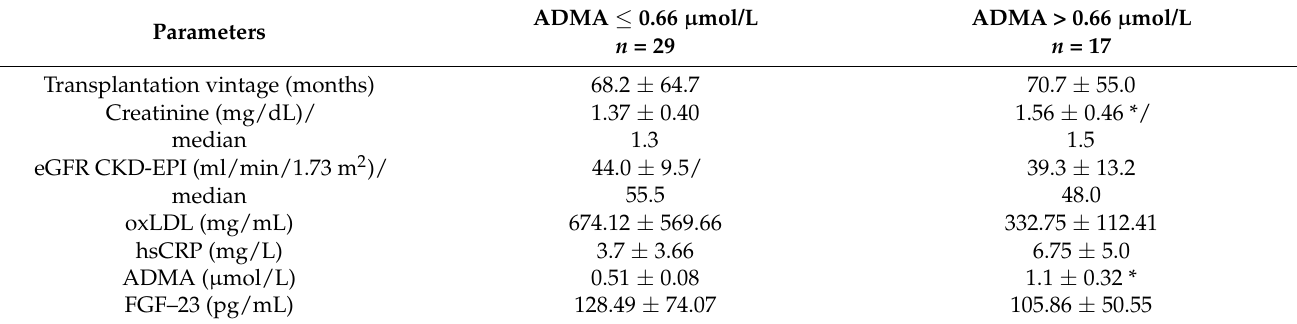
Table 2. The comparison between KTRs with ADMA ≤ 0.66 and > 0.66 µ mol/L.